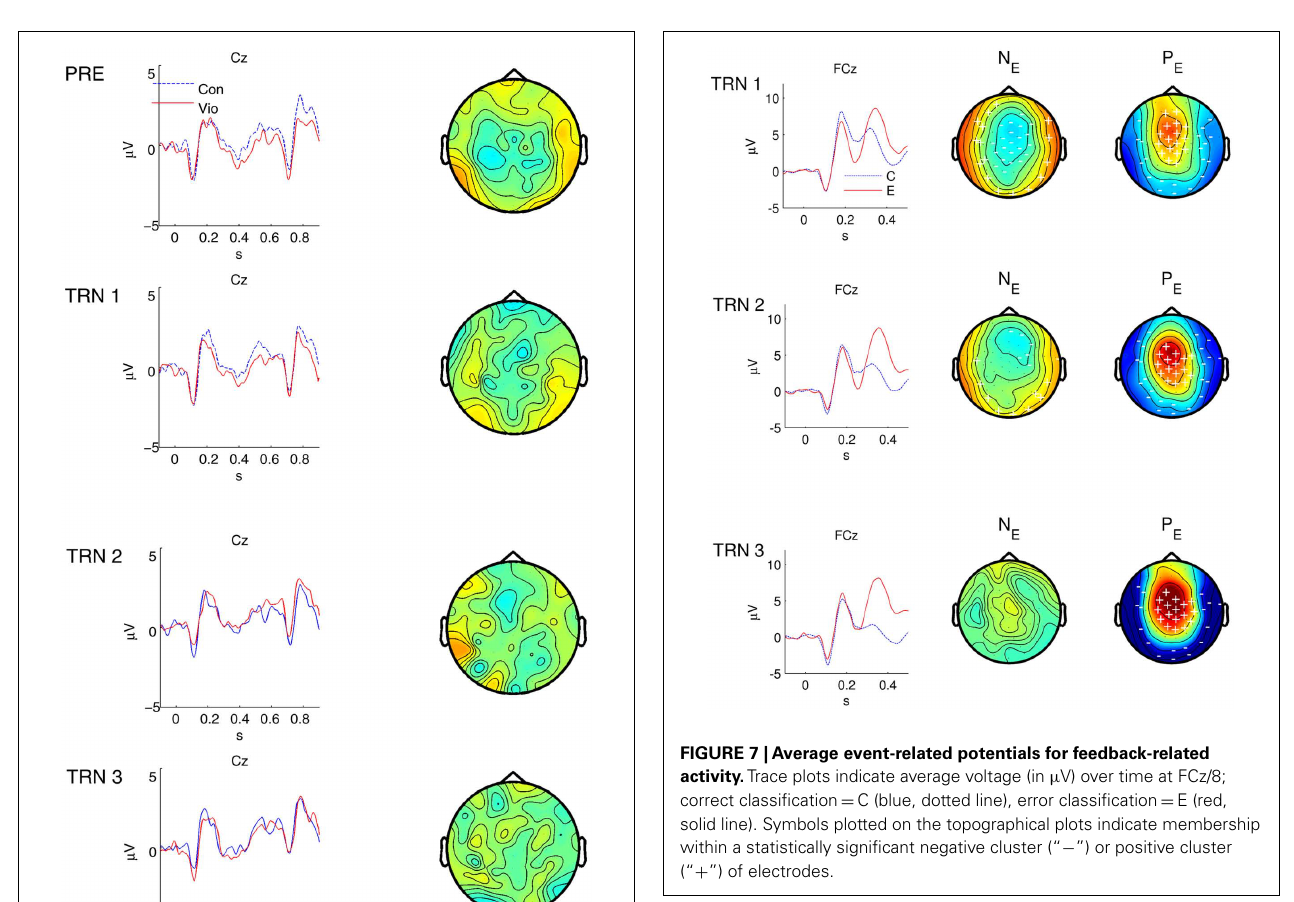
gender (masculine or feminine) of the nouns whose Dutch